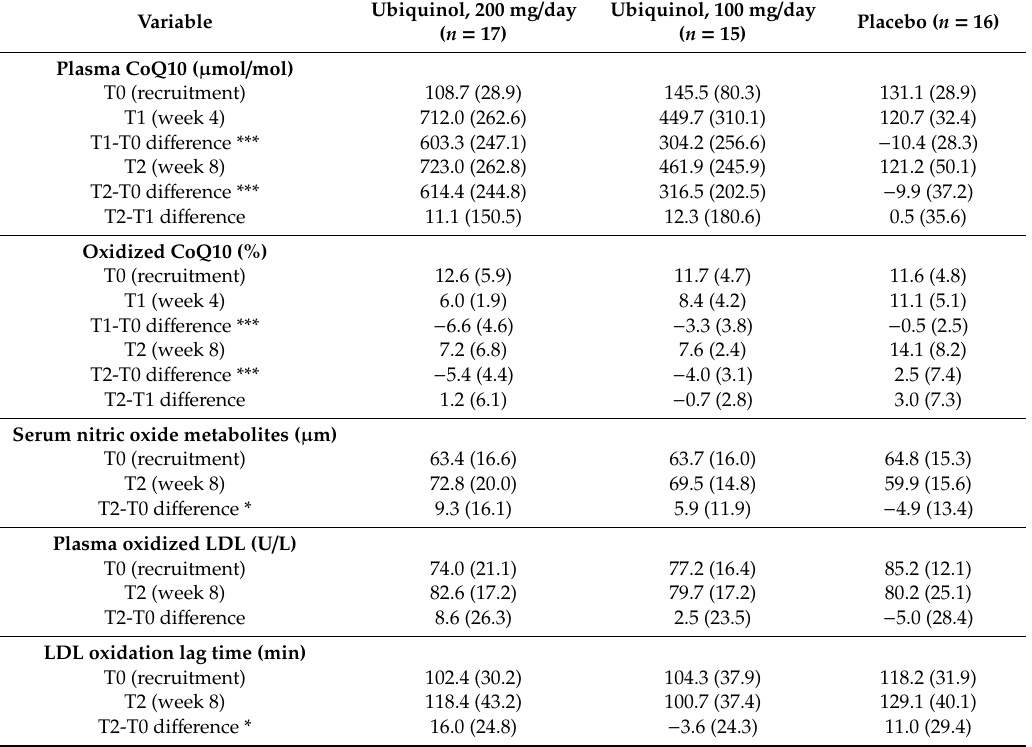
Table 3. Summary of the secondary endpoints (in bold) assessed in the per-protocol population ( n = 48) 1 .